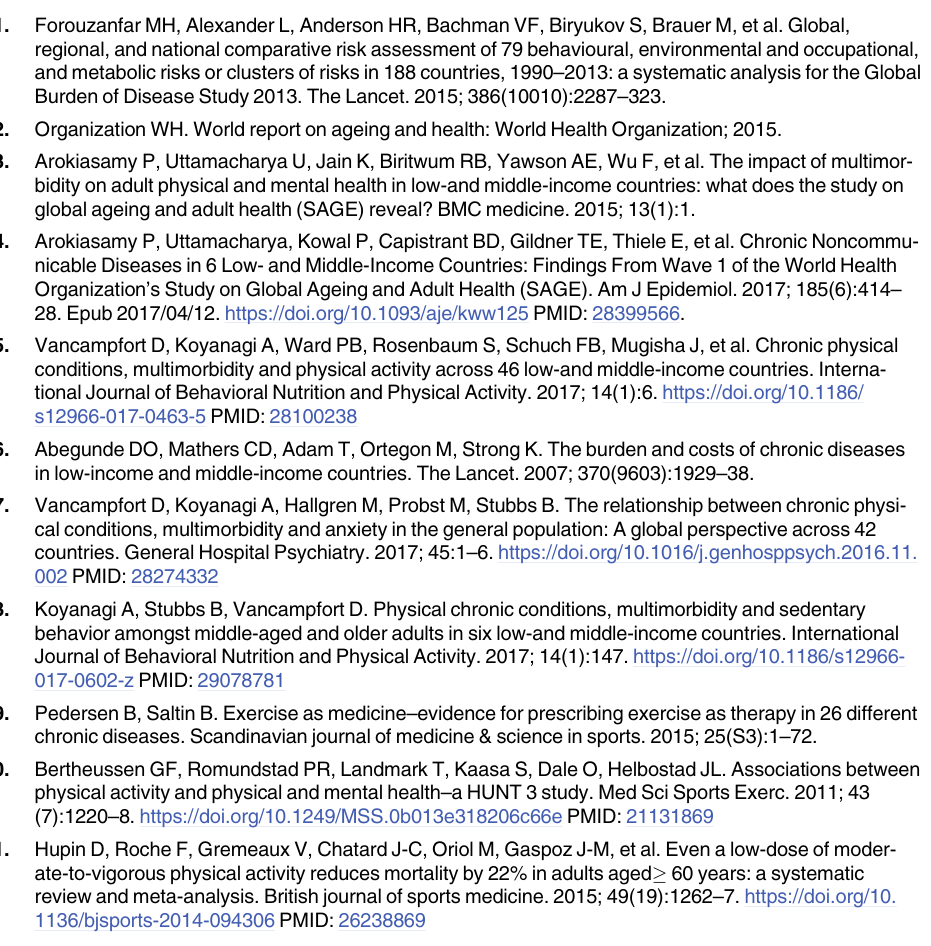
S2 Table. Questions used to assess mobility, affect, cognition, and